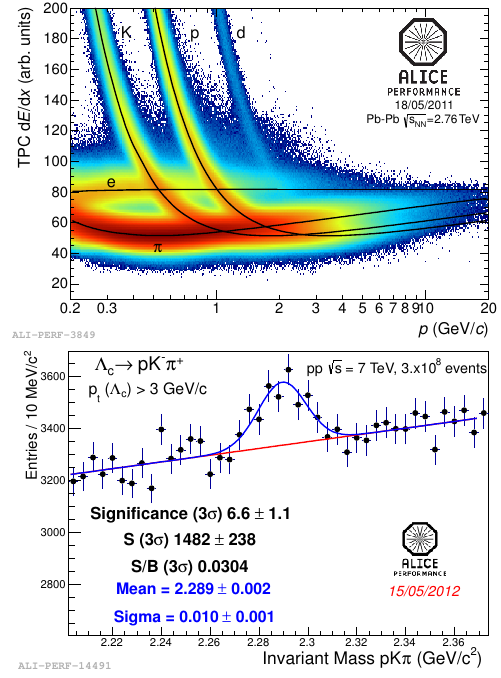
Figure 2. Top: Specific energy loss in the TPC as a function of momentum with superimposed Bethe-Bloch lines for various particle species. Bottom: Invariant mass spectrum of p K π at p T > 3 GeV / c in pp collisions at 7 TeV.